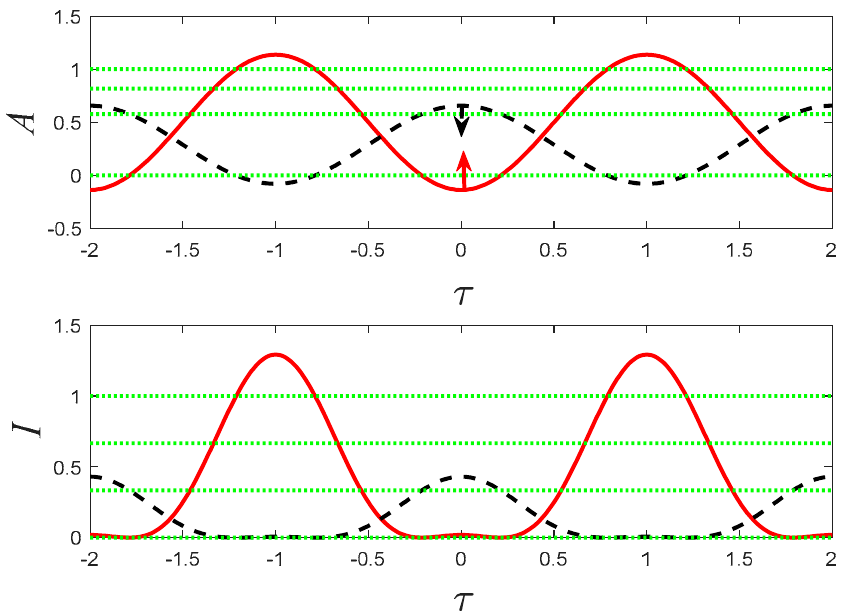
Figure 4. Two most detrimental sequences, which are responsible for closing the lower eye in 4-level pulse amplitude modulation (PAM-4).